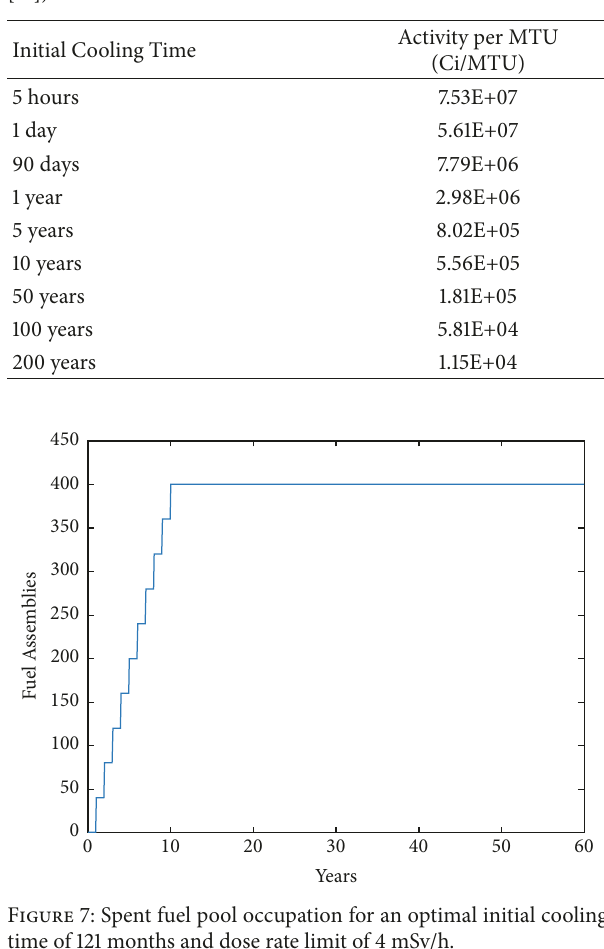
Table 5: Activity for all the isotopes in the spent fuel (adapted from [10]).